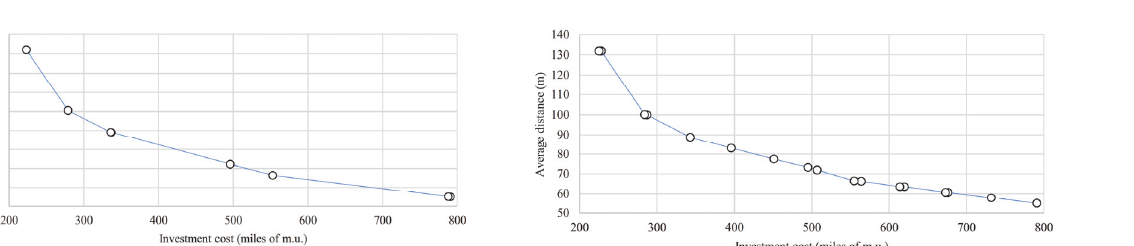
Fig. 1. Pareto front of the first scenario. Number of grid points = 20. Multi-objective approach = weighted-sum